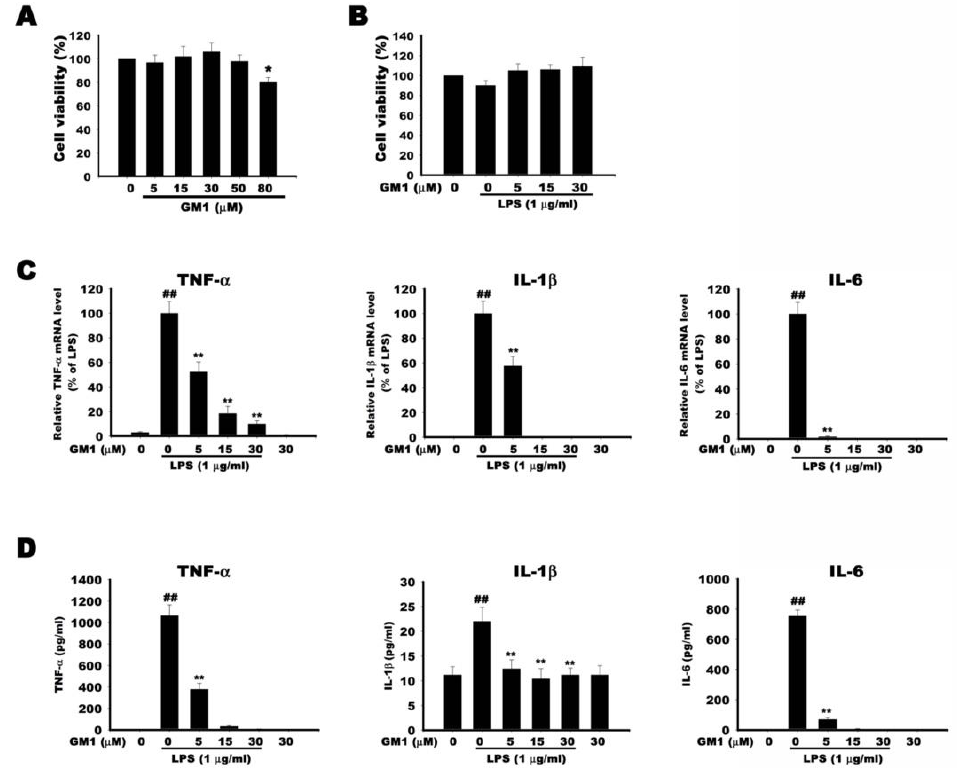
Figure 6. Effect of GM1 on the transcribed and secreted levels of proinflammatory mediators in LPS-stimulated RAW 264.7 cells. ( A , B ) Effect of GM1 with or without LPS stimulation on cell viability. Cells were treated alone with different concentrations of GM1 as indicated ( A ) or pretreated with GM1 for 1 h and then stimulated with LPS (1 µ g/mL) for 24 h ( B ). Cell viability was determined using a CCK-8 assay. Quantitative data are presented as percentages of the corresponding untreated control value (mean ± S.D., n = 3, quadruplicate wells for each condition). ( C ) Cells were pretreated with different concentrations of GM1 (5, 15, 30 µ M) and then stimulated with LPS for 6 h. mRNA expression levels for TNF- α , IL-1 β and IL-6 were measured by RT-qPCR. ( D ) Cells were pretreated with different concentration of GM1 (5, 15, 30 µ M) and then stimulated with LPS for 24 h. Secreted levels of TNF- α , IL-1 β and IL-6 were determined by ELISA. ## p < 0.01 compared with the control group; * p < 0.05 compared with the LPS-treated group; ** p < 0.01 compared with the LPS-treated